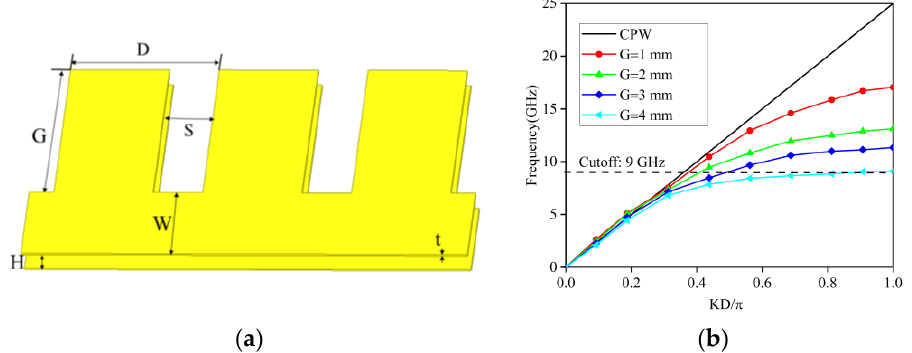
Figure 1. Structure and dispersive features of double-layered spoof surface plasmon polariton waveguide (DLSSPW). ( a ) Structure of DLSSPW. ( b ) Dispersive curves of the DLSSPW when groove depth varies.